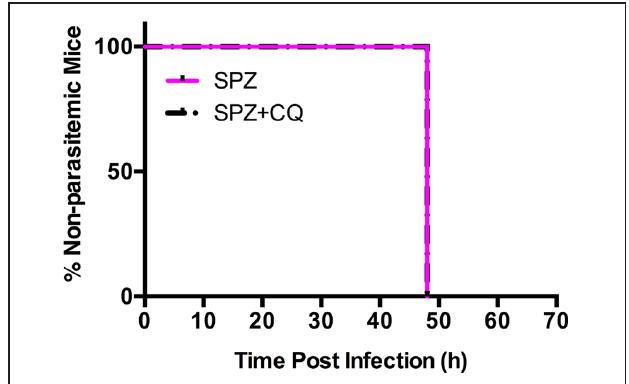
FIGURE 4 | Effect of CQ on prepatent period of Py -Luc. Mice ( n = 18) were infected with 1.5 × 10 4 Py -Luc salivary gland SPZ and either CQ-treated (SPZ + CQ; n = 9) or not (SPZ; n = 9). Blood smears (both thick and thin smears) were collected starting from 48 hpi. Smears were stained and examined by expert smear reader blinded. Smears are considered positive if minimum two parasites were found in 100 adjacent